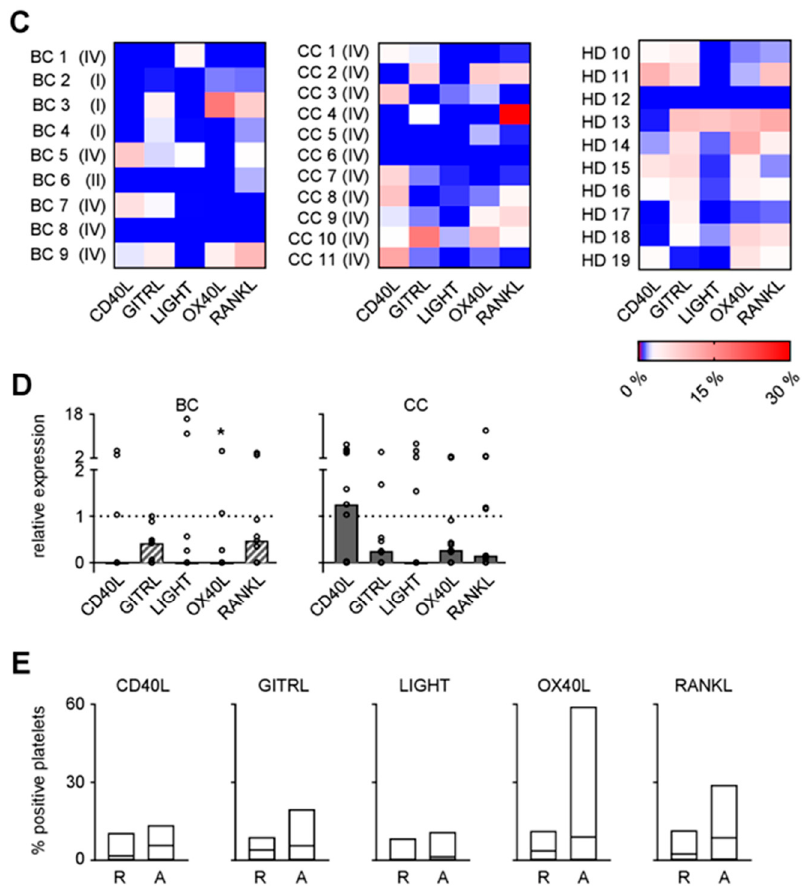
Figure 3. Expression of TNF family molecules on platelets. ( A–D ) CD40L, GITRL, LIGHT, OX40L, and RANKL surface expression on resting platelets from BC and CC patients and HD were investigated by flow cytometry after fixation with 2% paraformaldehyde ( n = 9, 11, and 10, respectively). ( A ) Representative results obtained from BC and CC patients and HD are shown. ( B ) The percentage of surface expression on platelets from HD is indicated. ( C ) Heatmap analysis of the expression profiles among the platelets of individual patients (disease stage as described in Table 1) and HD investigated. ( D ) Relative surface expression on platelets from BC and CC patients compared to HD is depicted. For combined analysis, the median percentage of positive platelets obtained from HD was set to 1 for each individual TNF family molecule analyzed (dotted lines). ( E ) The percentage of CD40L, GITRL, LIGHT, OX40L, and RANKL surface expression on resting (R) or activated (exposure to thrombin for 1 min, A) platelets from HD was analyzed by flow cytometry after fixation with 2% paraformaldehyde (R, n = 10; A, n = 6). ( B , D ) Median values of the respective group are depicted. ( D , E ) Statistically significantly different results ( p < 0.05) are indicated by *.